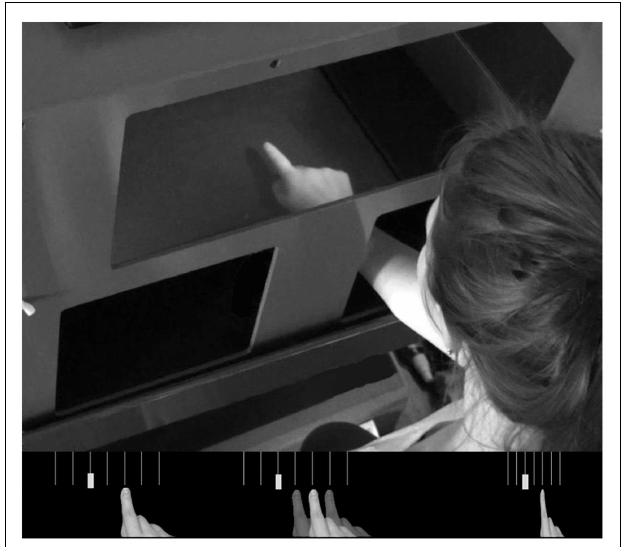
FIGURE 1 |Top panel; the MIRAGE mediated reality device used throughout the experiment . MIRAGE modifies real-time video capture of the real limb and displays it in the same plane as the actual limb. Bottom panel: a schematic representation of each condition. Left – Control; middle – Noise; right – Compression. Semi-opaque hands represent the addition of left and right noise perturbations.Vertical lines represent 3˚ separations in real space (not visible to participants). In each panel, the solid hand represents a real space reaching error of 6˚.